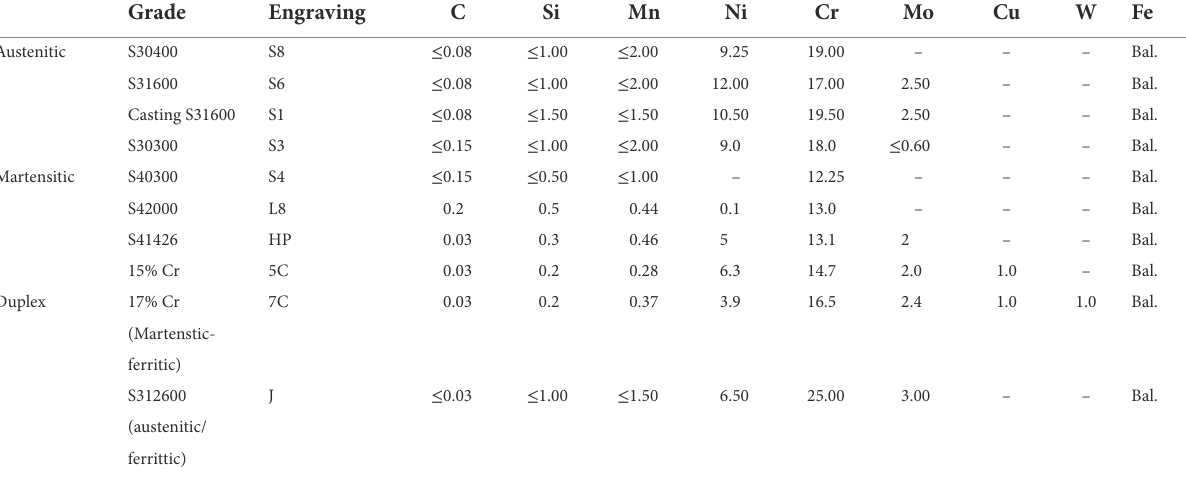
TABLE 1 Metals used in the immersion